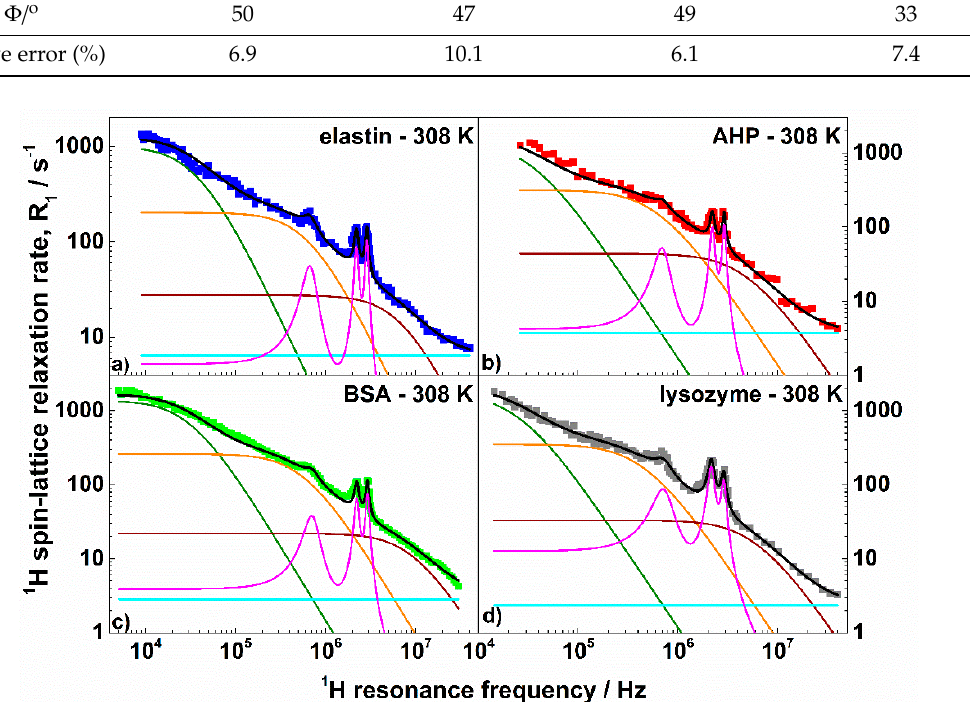
Figure 3. 1 H spin–lattice relaxation rates, R HH , for: ( a ) elastin, ( b ) AHP, ( c ) BSA, and ( d ) lysozyme in the solid state at 308 K. Black lines are theoretical fits decomposed into the individual relaxation contributions: R HH (green lines), R HH (orange lines), R HH (brown lines), A (light blue lines), and R HN (magenta lines).